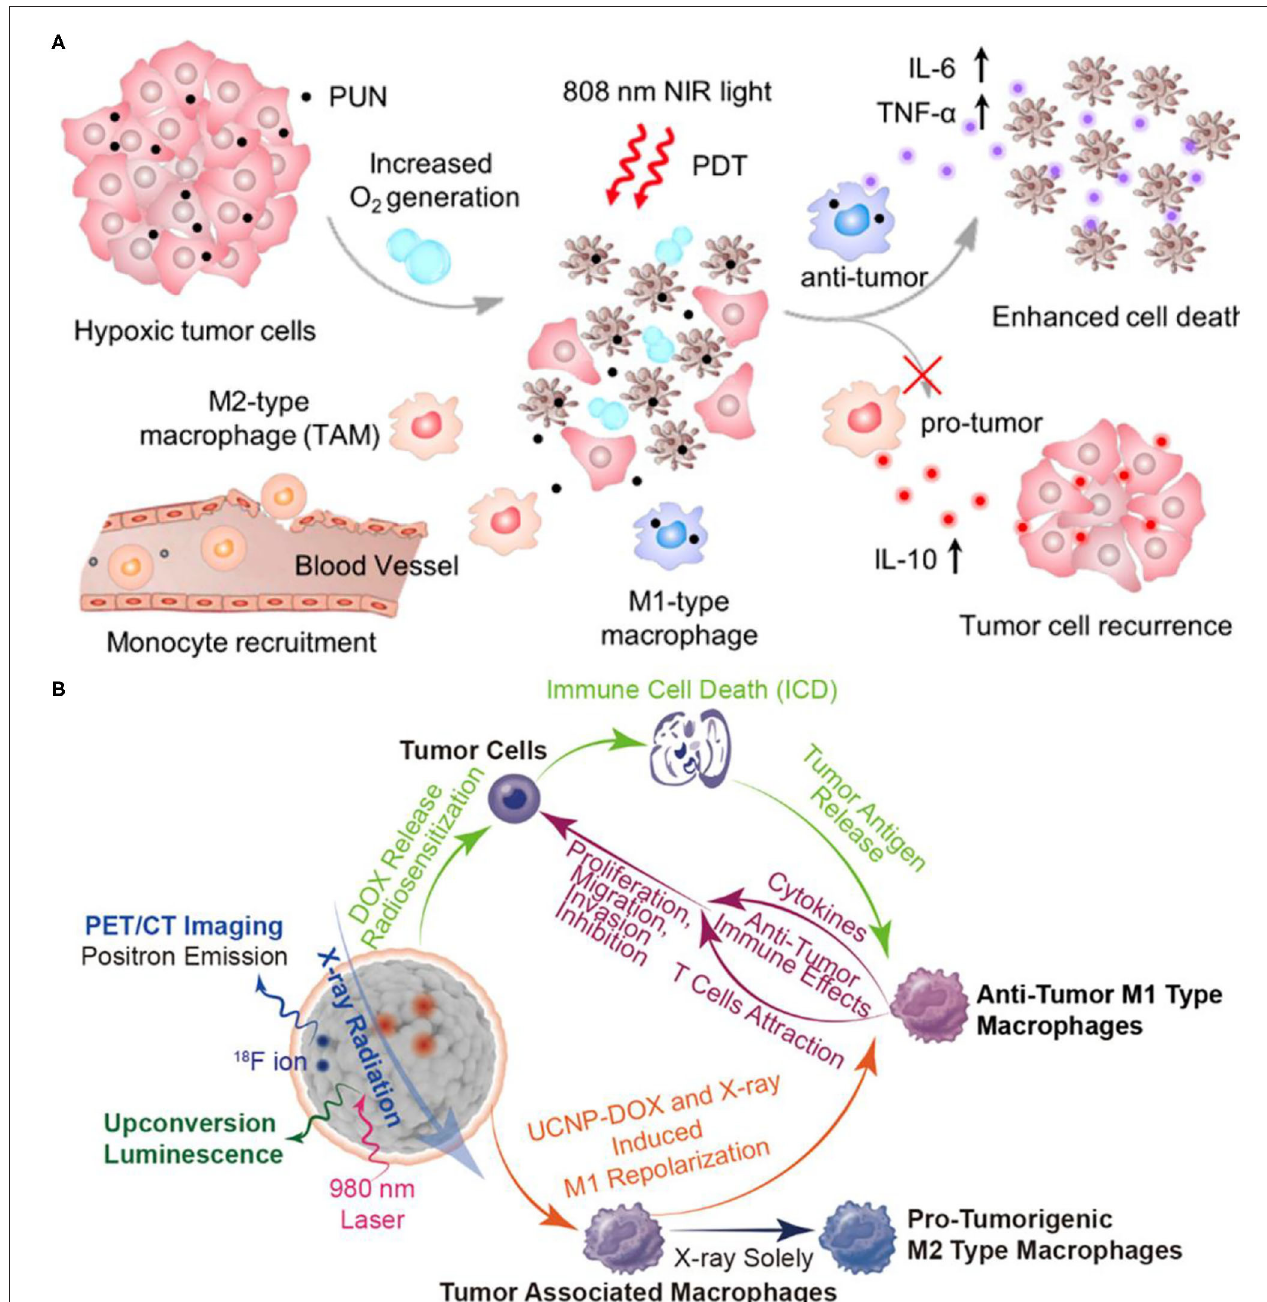
FIGURE 12 | (A) Scheme of improved therapy by attenuating hypoxia status and reprogramming tumor-associated macrophages (TAMs) from M2 to M1 phenotype to inhibit the recurrence of tumor cells toward immunotherapy during the post-PDT period. Copyright 2018, American Chemical Society (Ai et al., 2018). (B) Mesoporous Bi-Containing radiosensitizer loading with DOX to repolarize tumor-associated macrophages and elicit immunogenic tumor cell death to inhibit tumor progression. Copyright 2020, American Chemical Society (Qin et al., 2020).